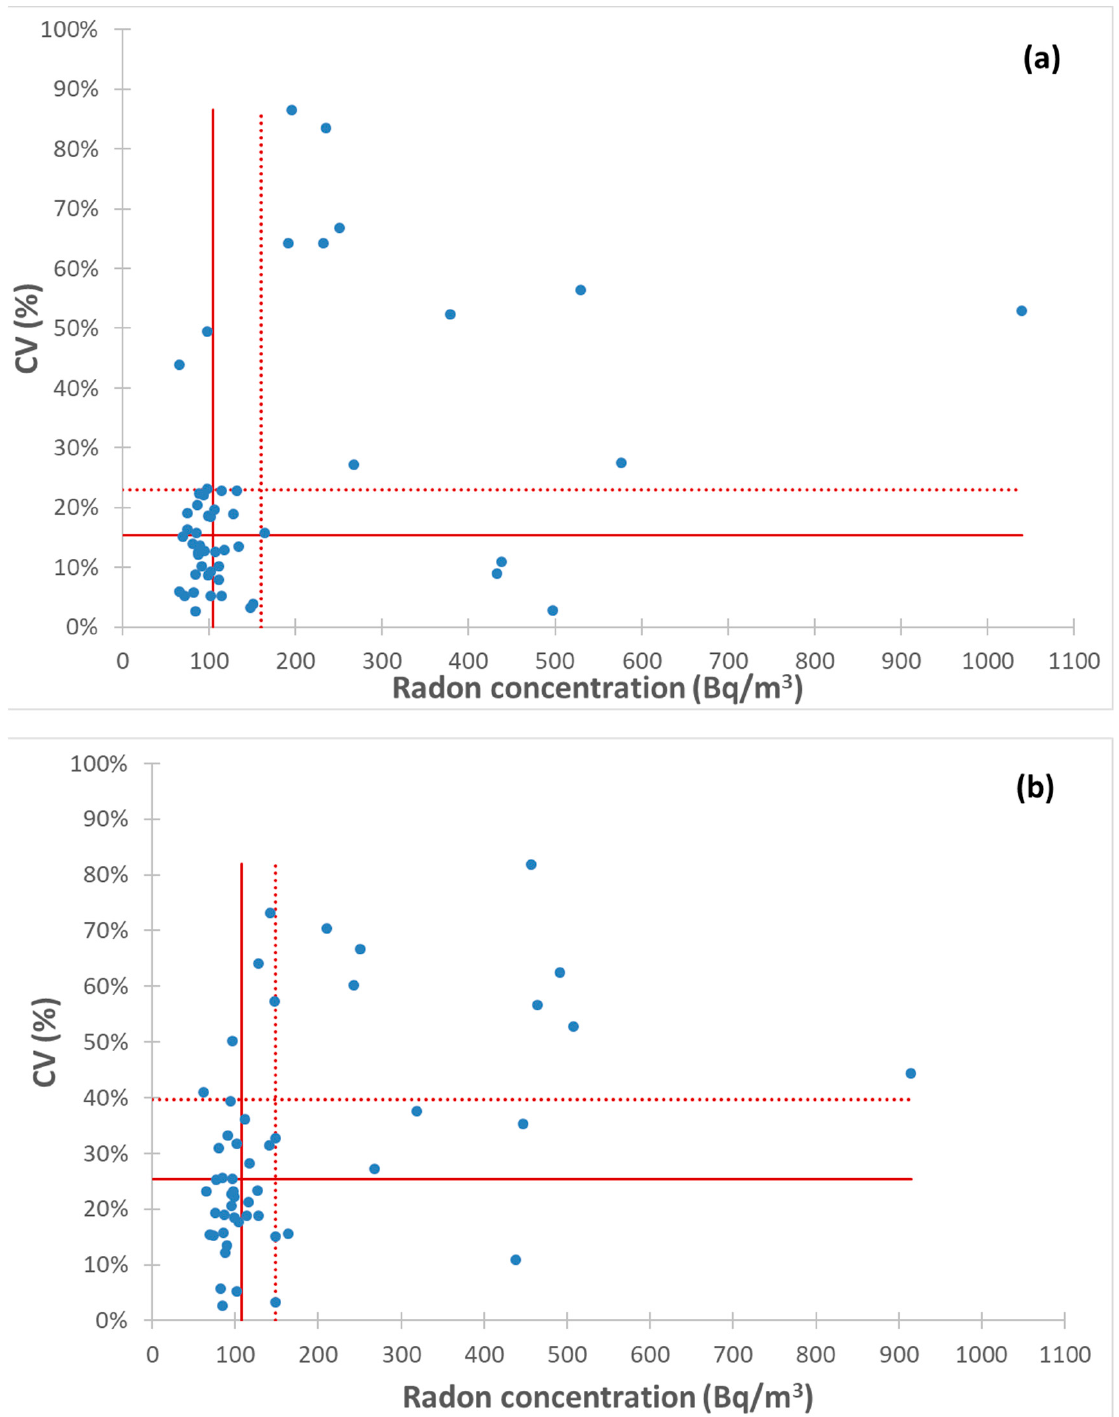
Figure 6. Coefficient of variation (CV) versus annual radon activity concentration (Rn) for each of 52 buildings with concentration value calculated as F_AM (average of floor means) ( a ), with concentration value calculated as R_AM (average of all concentration values) ( b ). Horizontal continuous and dotted lines intersect axis of ordinates in median and first quartile of CVs distribution (described in Table 4), respectively. Vertical continuous and dotted lines intersect axis of abscissa in median and first quartile of Rn distribution (described in Table 2), respectively. The differences between the CVs distribution of ( a , b ) are statistically significant (W-test p < 0.001).